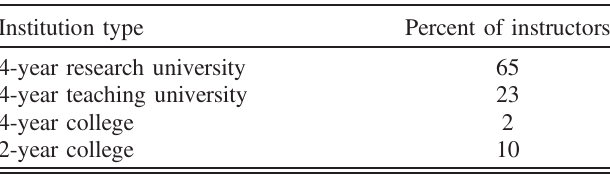
TABLE VI. The teaching experience of the interviewees. Teaching experience Percent of instructors First time teaching an IPLS course Taught IPLS courses for a long